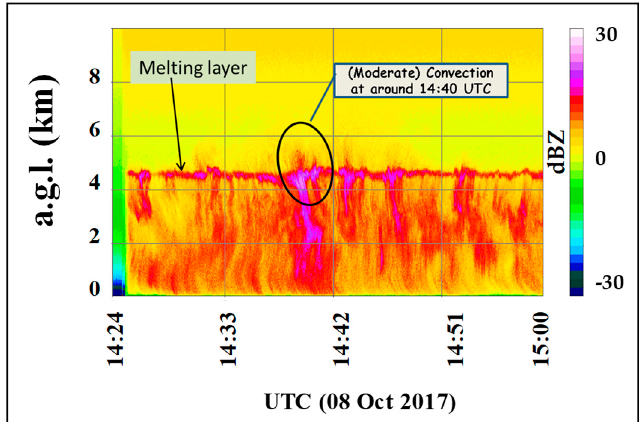
Figure 7. Time series of vertical profiles of reflectivity from the vertically pointing XPR observations for 14:24 to 15:00 UTC on 08 October 2017.